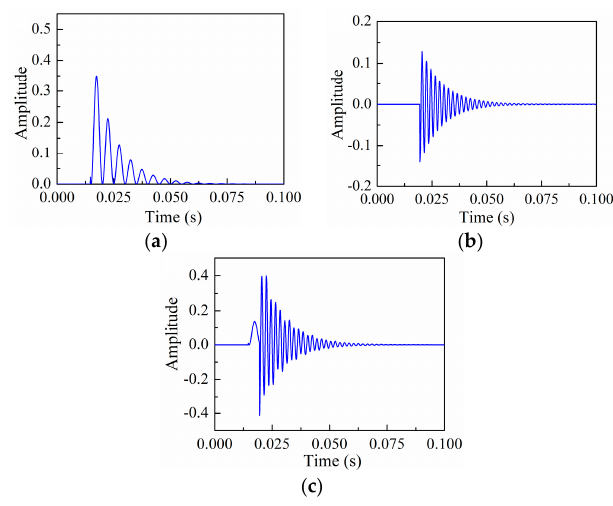
Figure 5. Single-cycle bearing fault signal model. ( a ) The time domain waveform of step signal; ( b ) The time domain waveform of impact signal; ( c ) The time domain simulation waveform for quantitative analysis of bearing faults. f = 500 . The multi-cycle time domain n